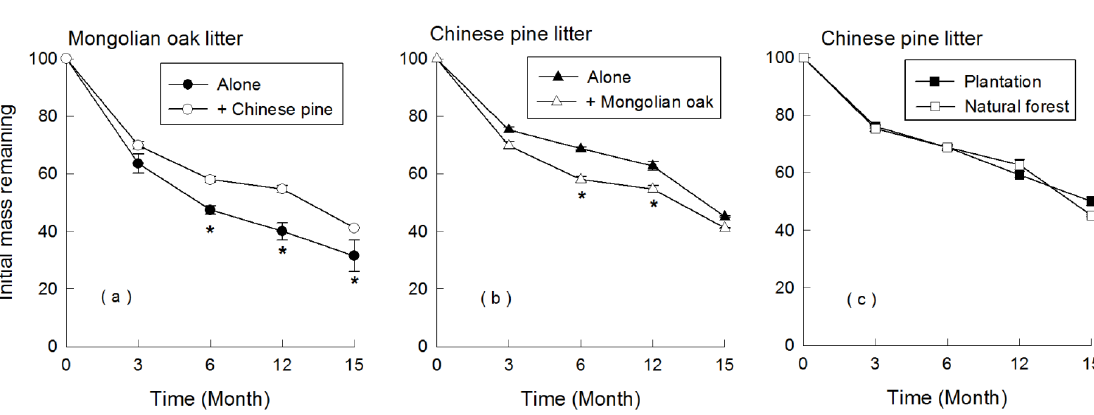
forest; ( b ) Chinese pine litter in the natural forest; and ( c ) Chinese pine litter in either plantation or natural forest. Error bars represent the standard errors of the means ( n = 3). Asterisk indicates significant difference at p < 0.05.